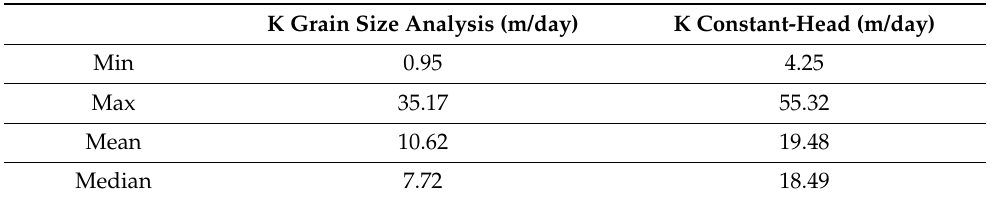
Table 2. The hydraulic conductivity measurement by Al-Amri [13] using grain-size analysis and constant-head method.